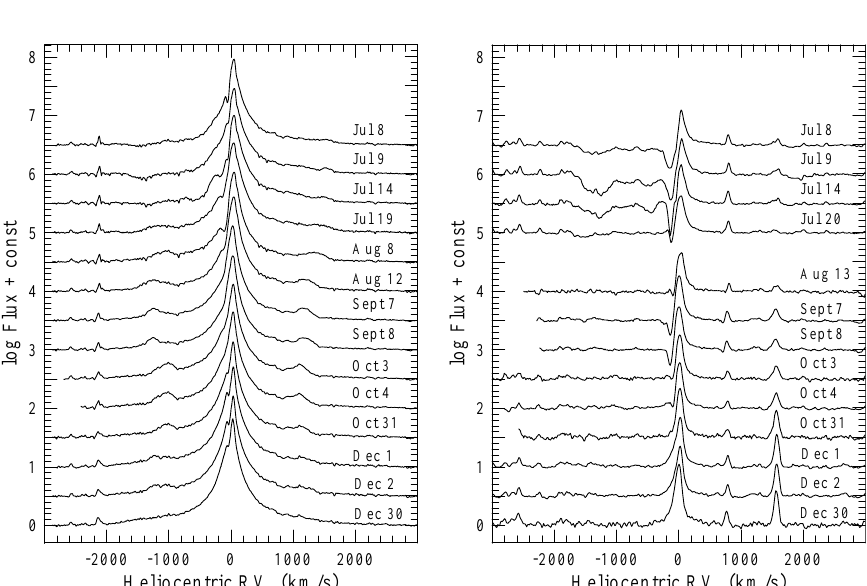
Fig. 2. Time evolution of the H (cid:11) (left panel) and H (cid:13) (right panel) lines. wavelength side of the central component is seen in the spectrum of August 8 and the dip feature between them indicates a moderate velocity of about 100 km s − 1